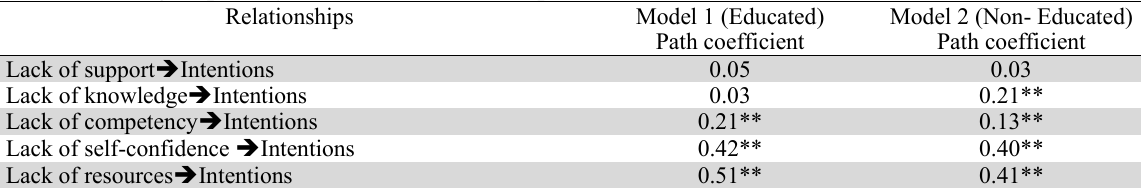
Relationships Model 1 (Educated) Model 2 (Non- Educated) Path coefficient Path coefficient Lack of support  Intentions 0.05 0.03 Lack of knowledge 